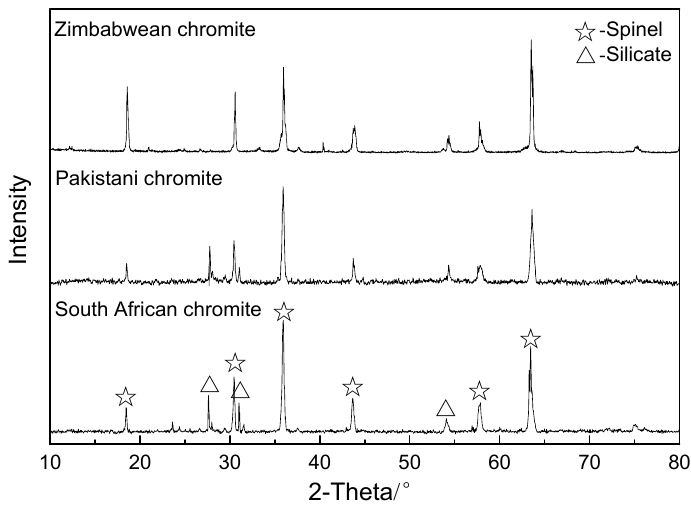
Figure 1. X-ray di ff raction (XRD) patterns of chromites used in this Figure 1. X-ray diffraction ( XRD) patterns of chromites used in this study.